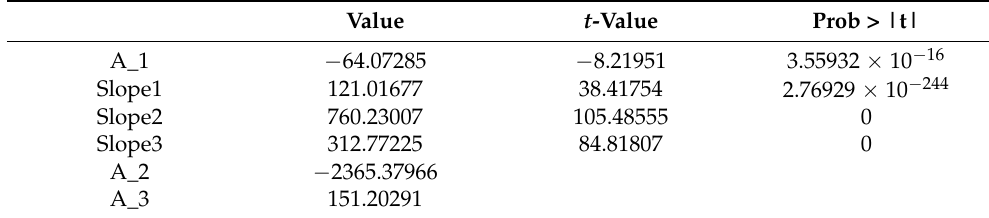
Table 4. Test parameters for significance of fitting curve (blue curve) of Figure 12b.